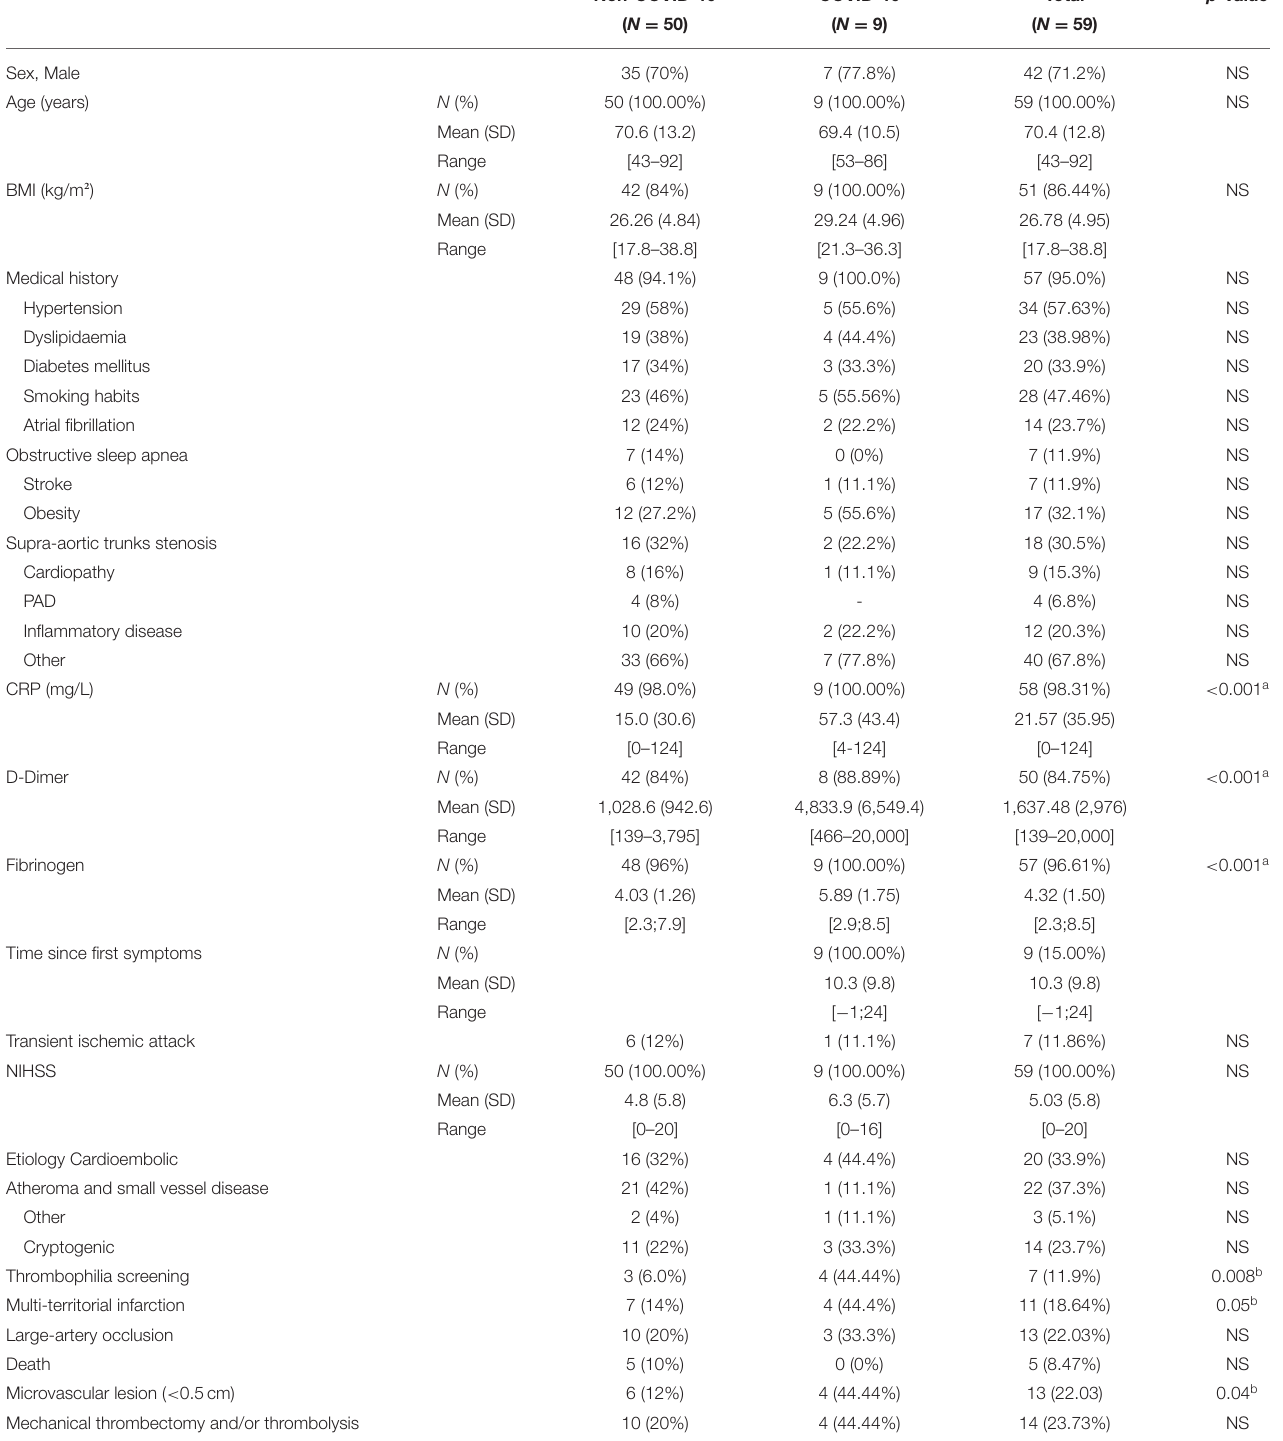
TABLE 2 | Demographic, clinical, biological, and radiological data and mechanism in COVID-19 and control group.